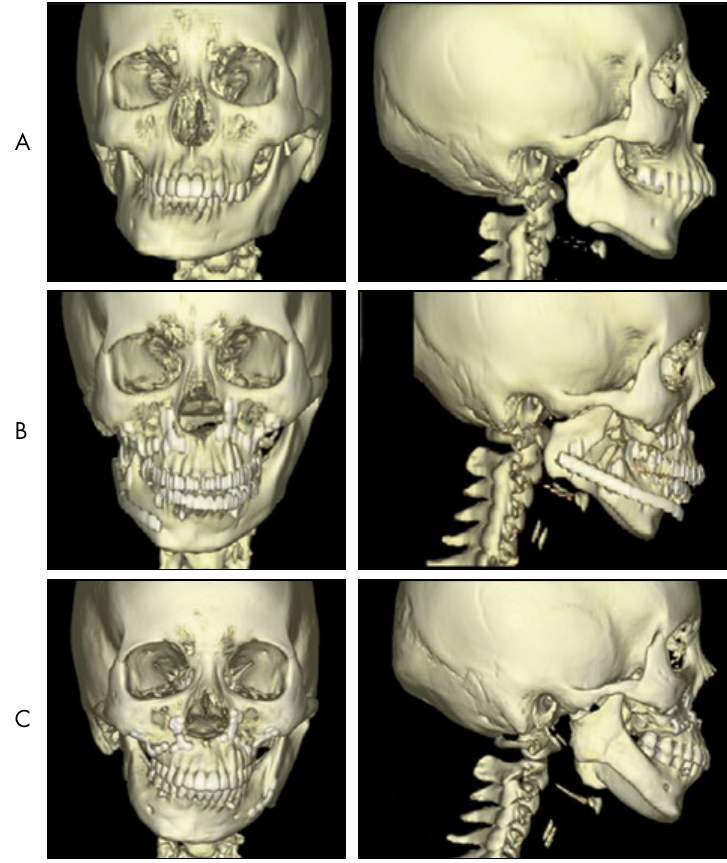
Figure 6. CT images. A: pretreatment; B: pre-surgery; C: post-retention, two years and six months after